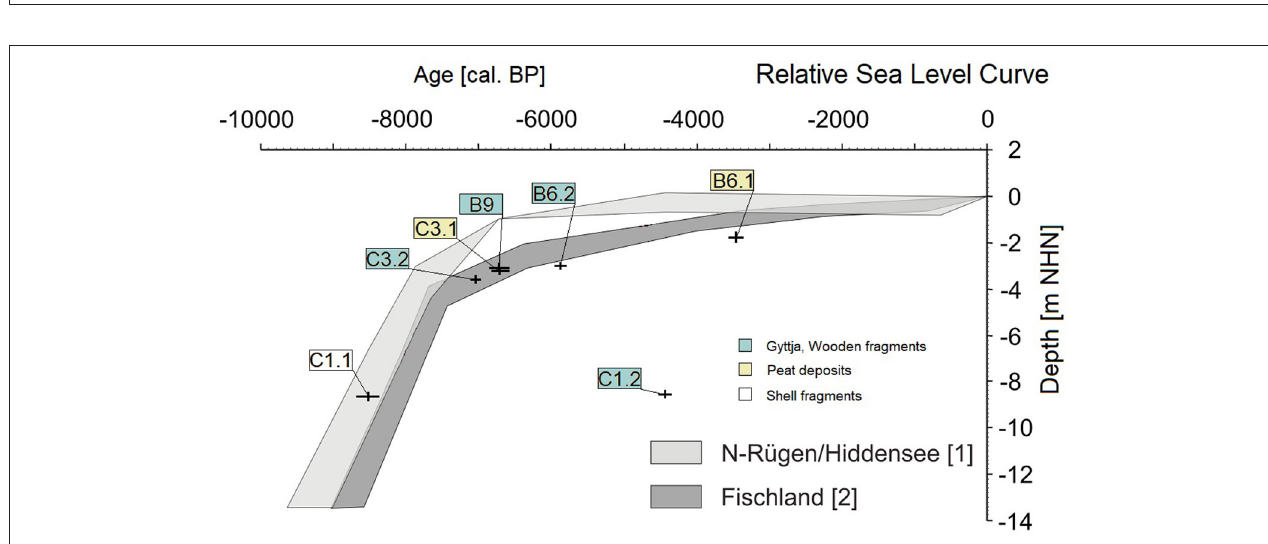
FIGURE 6 | Local Holocene sea level curve based on Lampe et al. (2010) with age/depth relationships obtained in this